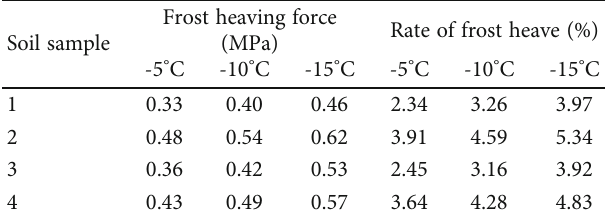
Figure 2: Diagram of freezing heave test device. Table 2: Maximum frost heaving rate and frost heaving force of di ff erent soil